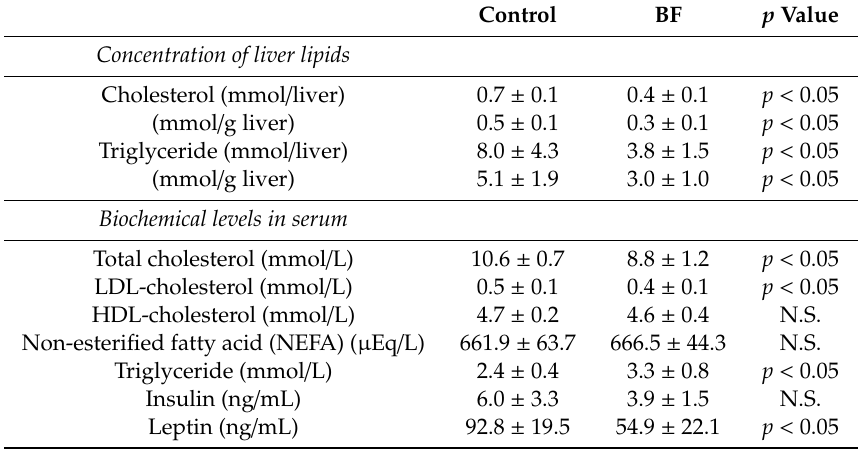
Table 5. Concentrations of liver and serum lipids and hormones in mice fed the control and BF